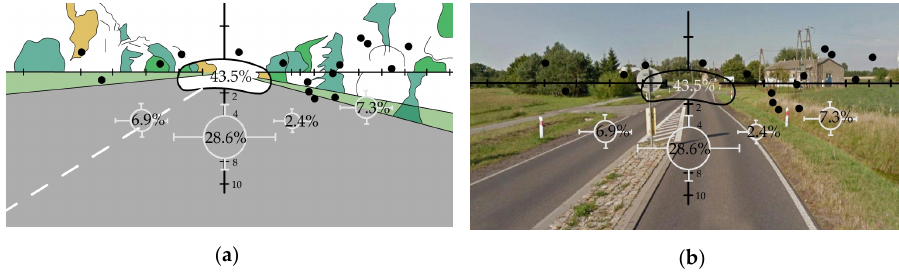
Figure 9. Distribution of fixation points in different driving conditions: ( a ) using the data from [14]; ( b ) with 70 km/h speed limit indicated by the B-33 sign).